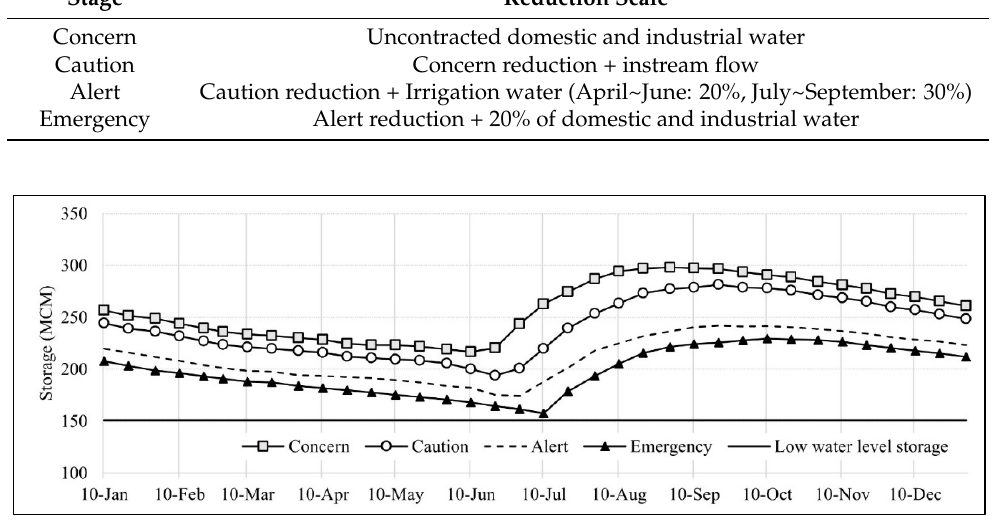
Figure 3. An example of Standard for the Hapcheon reservoir. This Standard is set in four stages (concern, caution, alert, and